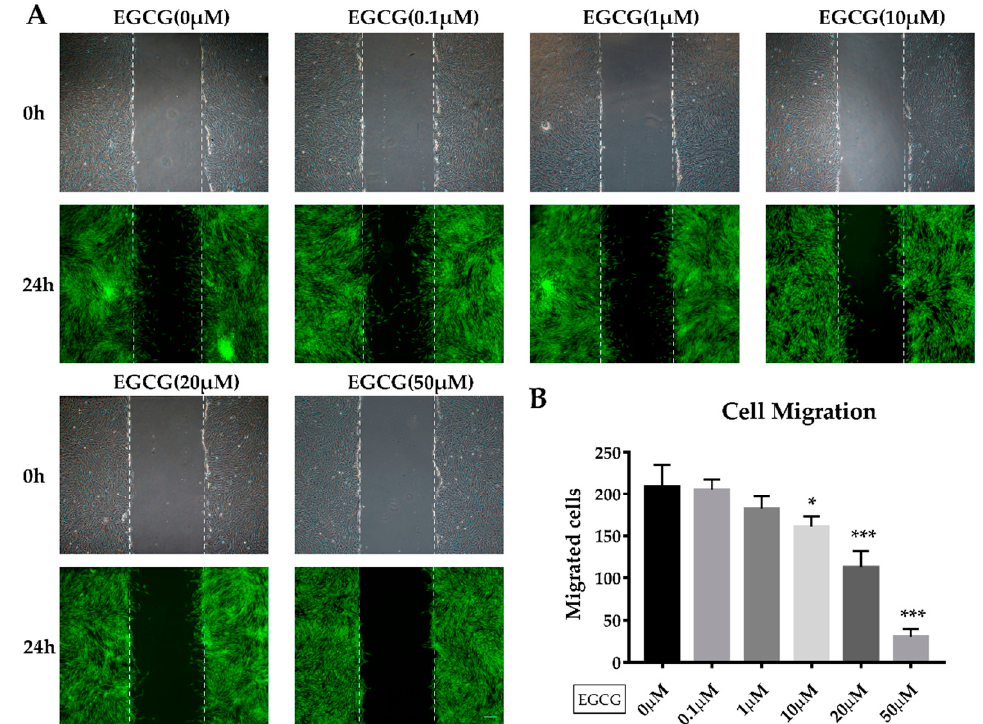
Figure 3. The migration of SCAPs treated with different doses of EGCG. ( A ) The representative images of the wound- images of the wound-healing assay were obtained at 0 and 24 h after treatment with different healing assay were obtained at 0 and 24 h after treatment with different concentrations of EGCG. ( B ) Migrated cells were concentrations of EGCG. ( B ) Migrated cells were counted in each group after 24 h. EGCG at low counted in each group after 24 h. EGCG at low concentrations exhibited no significant effect compared with the control concentrations exhibited no significant effect compared with the control group, while over 10 µ M of group, while over 10 μ M of EGCG inhibited the migration of SCAPs. Scale bar = 200 μ m. (* p < 0.05, *** p < 0.001). Error EGCG inhibited the migration of SCAPs. Scale bar = 200 µ m. (* p < 0.05, *** p < 0.001). Error bars: bars: mean± standard deviation. mean ± standard